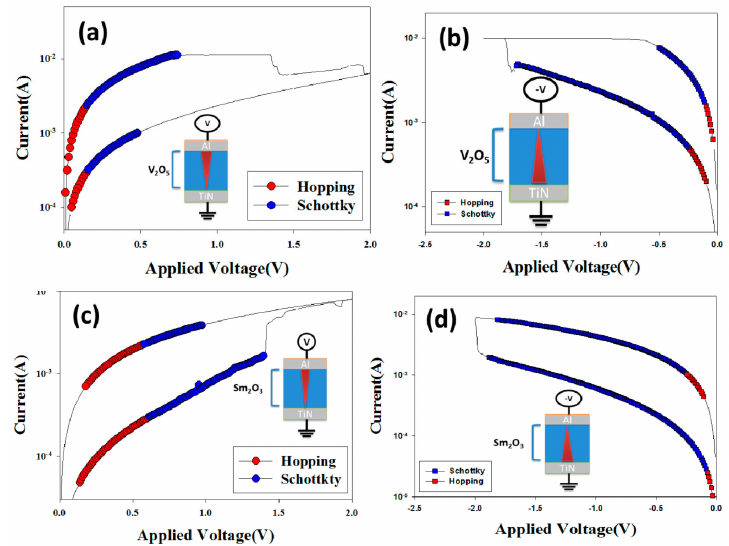
Figure 4. The electrical conduction mechanism and metal filament path model of the self-compliant Sm 2 O 3 and non-compliant V 2 O 5 thin film RRAM devices for positive and negative